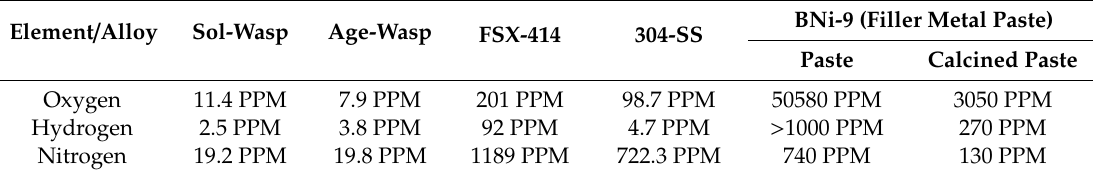
Table 3. Oxygen, hydrogen, and nitrogen contents in the Waspaloy alloys for the solubilized and aged Sol-Wasp and Age-Wasp, respectively, FSX-414, 304-SS, and BNi-9 (filler metal paste). Element /